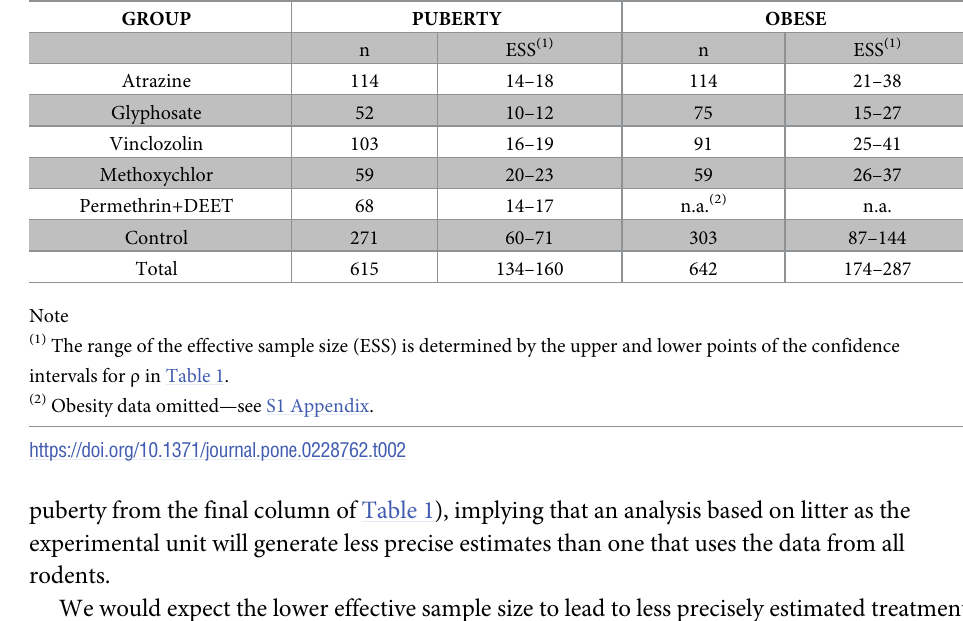
Table 2. Numbers of observations and effective sample sizes at F3 by group and outcome.